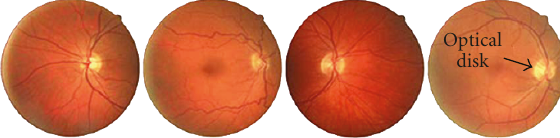
Figure 1: Eye anatomy [15].